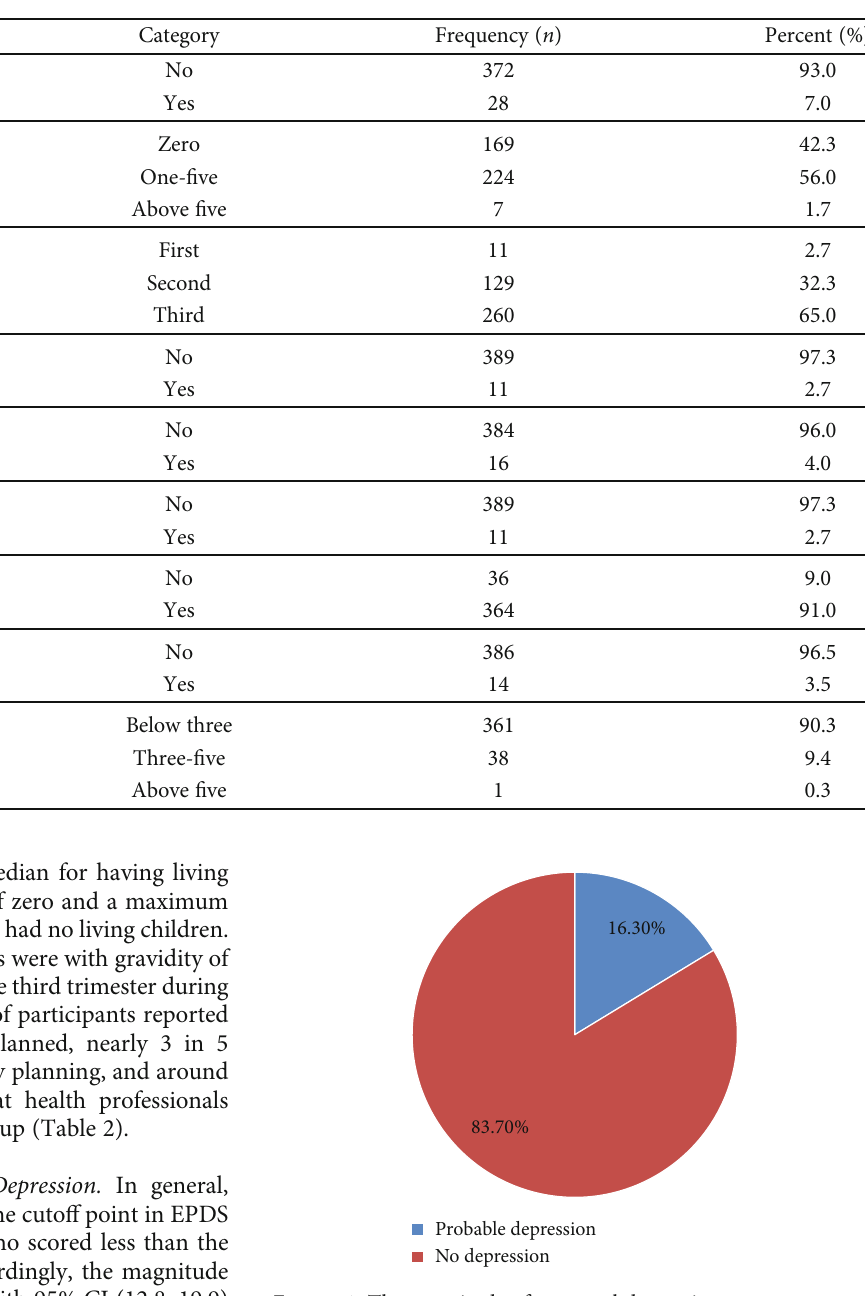
Table 2: Obstetric characteristics of pregnant women ( n = 400 ) attending antenatal care in Sodo town health facilities, Southern Ethiopia, 2017.